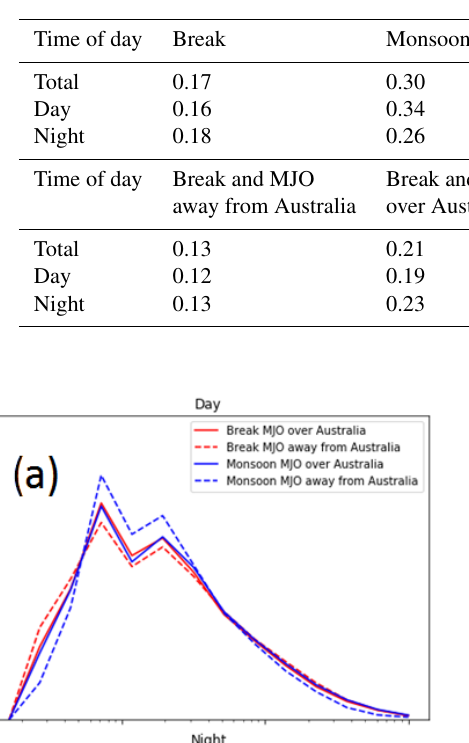
Table 1. The normalized frequency of MCSs identified using the criteria of Rowe and Houze (2014) in the radar domain per scan for the given MJO and monsoonal conditions.